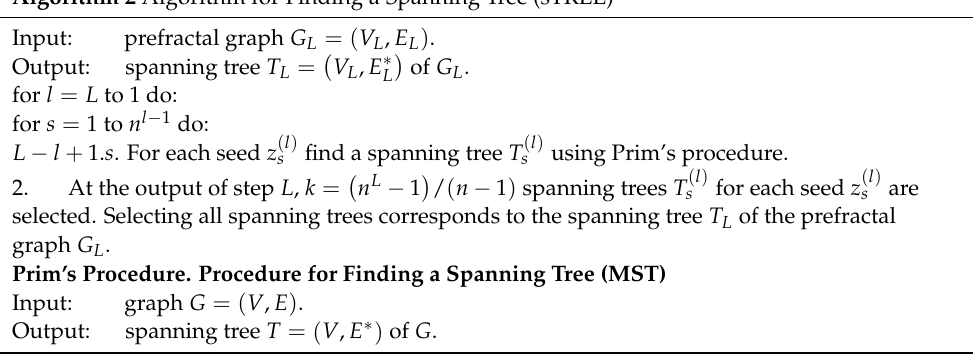
Algorithm 2 Algorithm for Finding a Spanning Tree